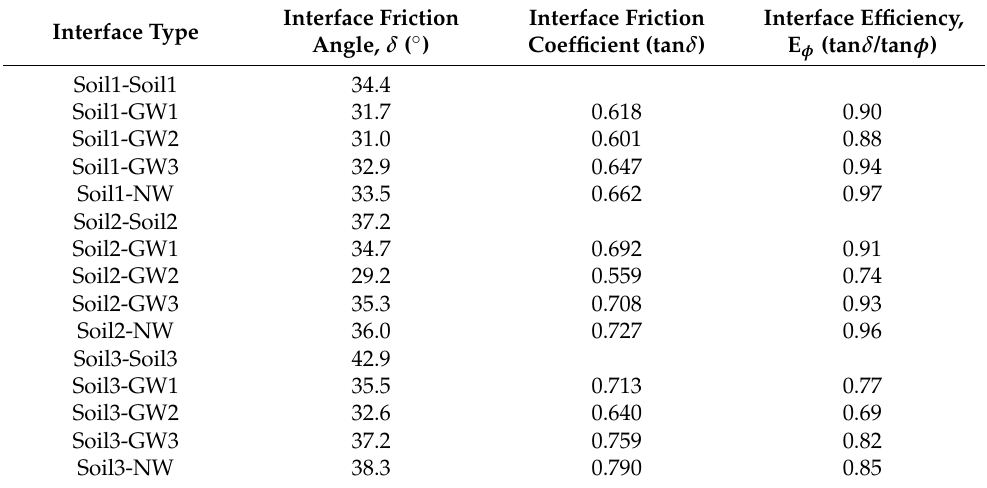
Table 3. Interface friction parameters including friction angles, friction coefficient, and interface efficiency from modified direct shear